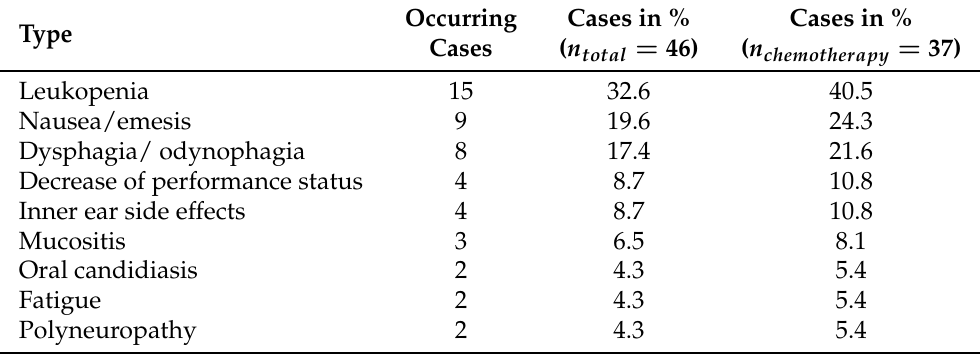
Table 2. Acute side effect of chemotherapy and its proportion in the total population and proportion in the chemotherapy